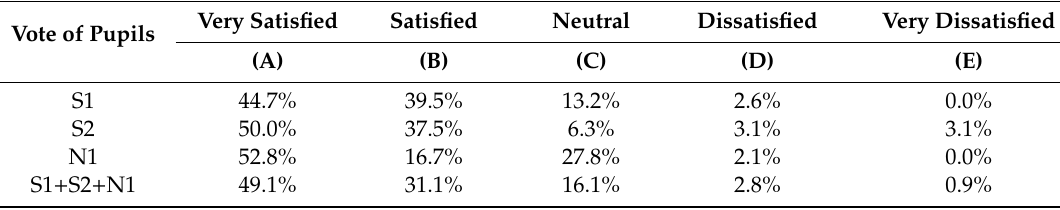
Table 8. S1, S2 and N1 satisfied (with the air quality)